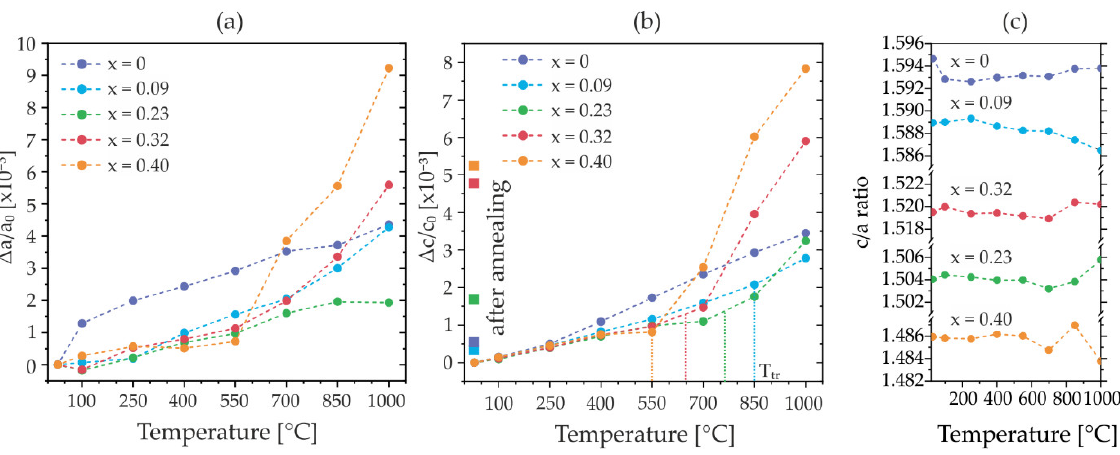
Figure 6. XRD in situ (with oxygen atmosphere) characterization of thermal evolution of the lattice parameters (sample set #2). ( a ) Relative change in the lattice parameter a and ( b ) lattice parameter c indicating a high-temperature regime of isotropic thermal expansion and estimated values of the transition temperature T tr . Dashed lines serve as a guide to the eye only. Residual values of lattice expansion after annealing are shown as square data points as given in Table 2. ( c ) Calculated c / a ratios showing approximately isotropic thermal expansion for the investigated thin films across the full temperature range.